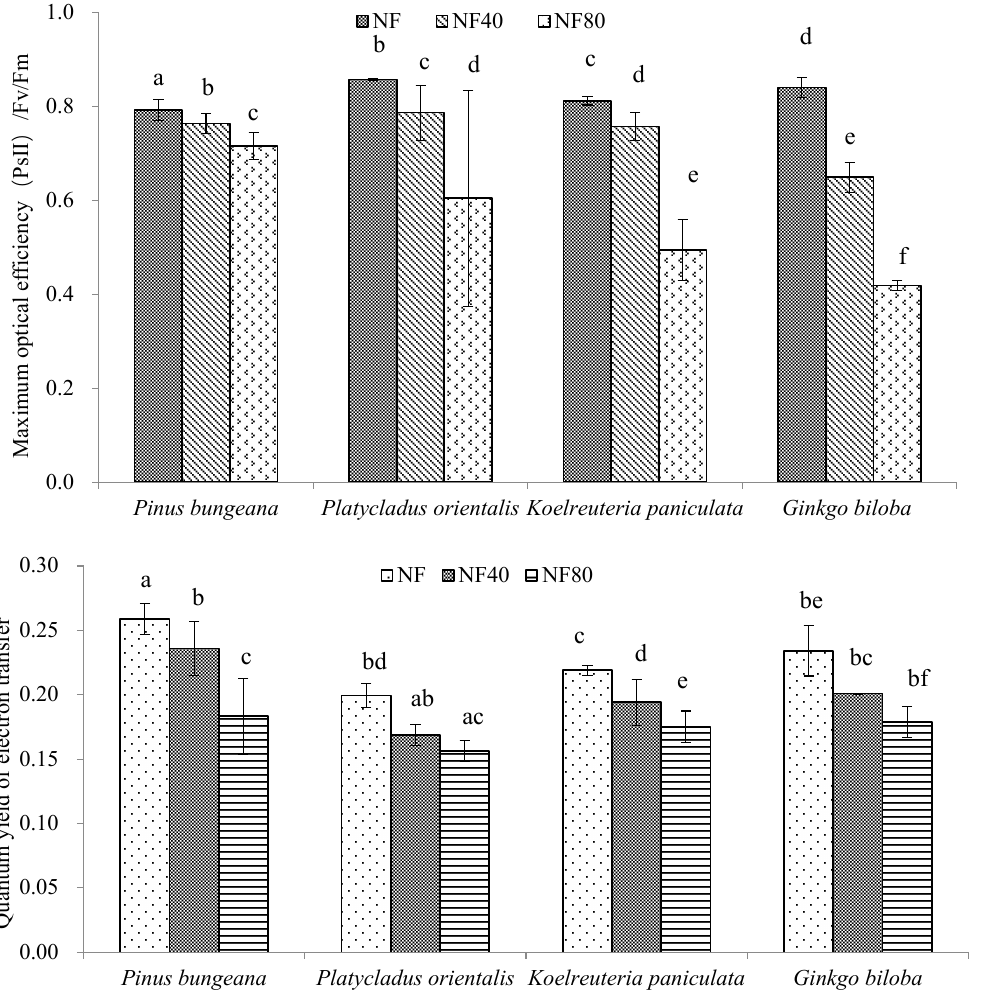
Figure 1. Changes in photochemical efficiency of trees under different ozone concentrations. Different letters indicate that there are significant differences between different ozone treatments ( p < 0.05).